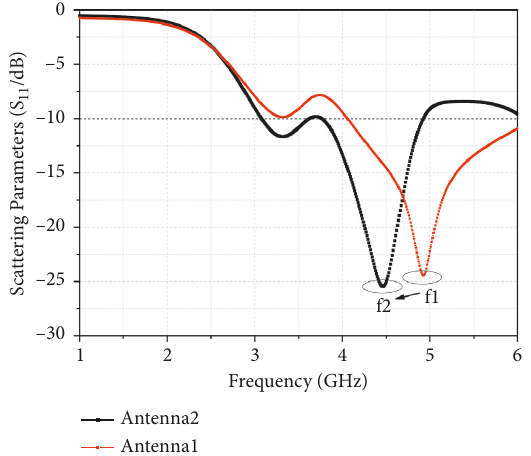
Figure 6: The imaginary parts of input impedance of antenna 2 and antenna 3.